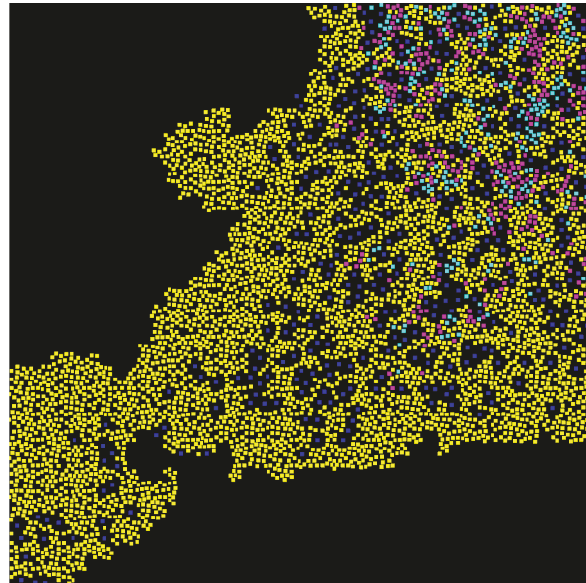
Figure 12: In this example, the blue plant species belongs to the largest plant level, while the other plant species belongs to the smallest plant level. The blue plant species has a negative neighboring effect on the other plant